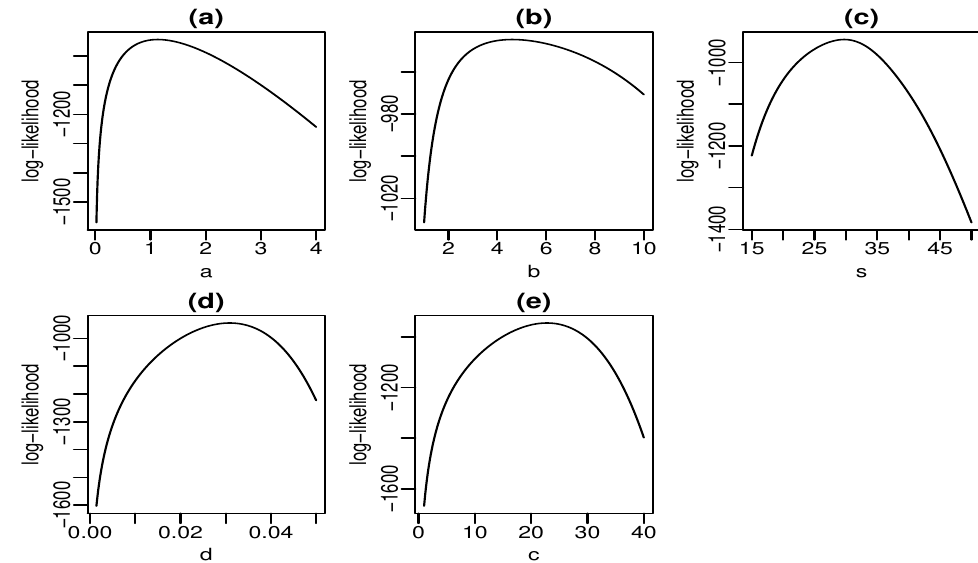
Figure 6. Profile log-likelihood functions for skin folds data ( a – e